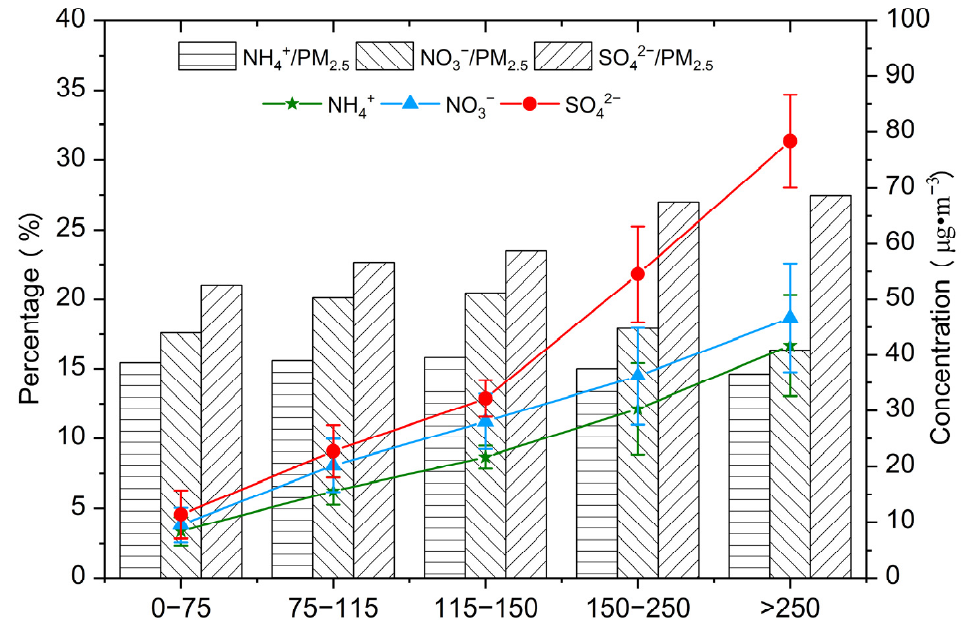
Figure 4. Concentrations of secondary inorganic aerosols (SIAs) and their ratios in PM 2.5 during different air qualities in Shihezi.